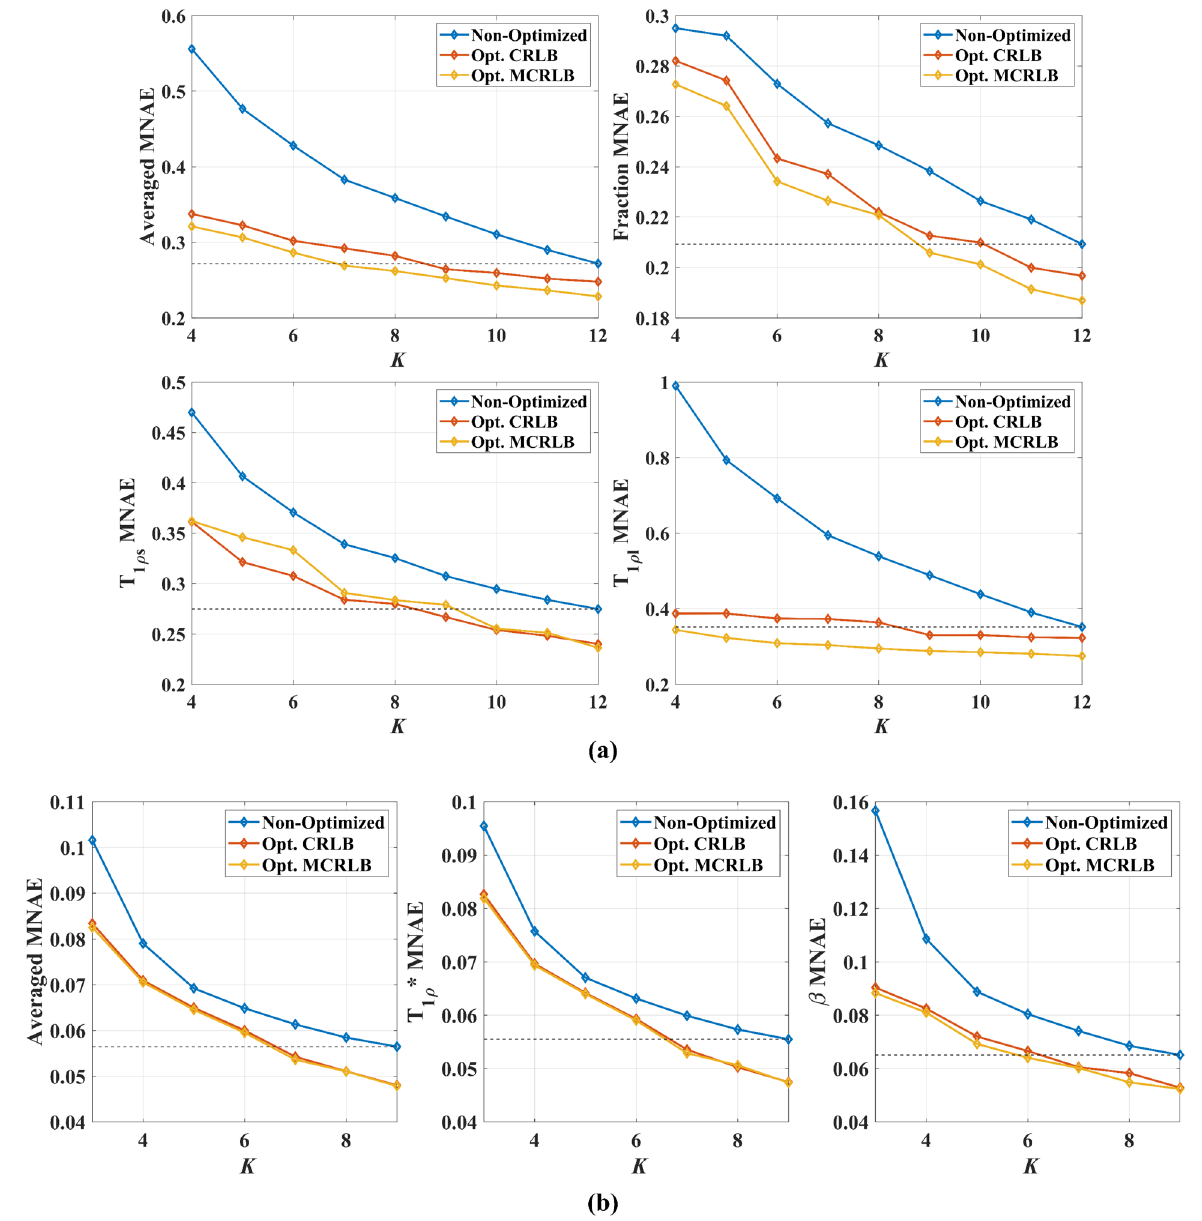
Figure 1. A weighted average of MNAE ( a ) for estimated bi-exponential parameters, MNAE for the fraction, short T 1ρ , and long T 1ρ versus K . The optimized sampling schedules resulted in lower errors for the entire range, and the MCRLB optimized schedule was the top performer. Interestingly, the CRLB schedule performed better for the estimation of long T 1ρ . This is probably due to the longer TSLs employed. In ( b ) Weighted average of MNAE for estimated stretched-exponential parameters, MNAE for the T 1ρ *, and β versus K . Errors are much lower than for the bi-exponential model, and so is the gain over the non-optimized schedule. The differences between CRLB and MCRLB schedules also become smaller. The black dashed line indicates the minimum error obtained using the non-optimized schedule. The optimized schedules can reach this line before the non- optimized schedules, leading to lower acquisition